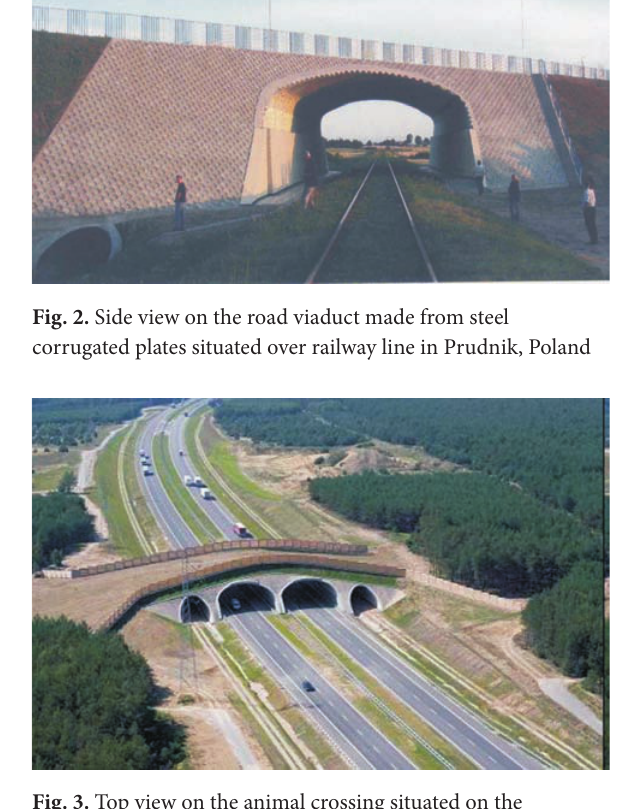
fig. 3. Top view on the animal crossing situated on the motorway in Poland (Bednarek, Czerepak